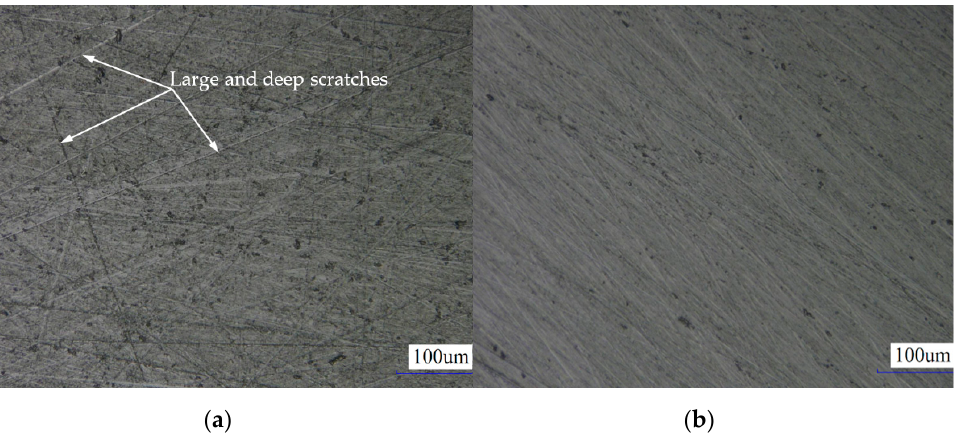
Figure 13. ( a ) Overall surface morphology at i pw = 1, and ( b ) overall surface morphology at i pw = 0.3819…, respectively.